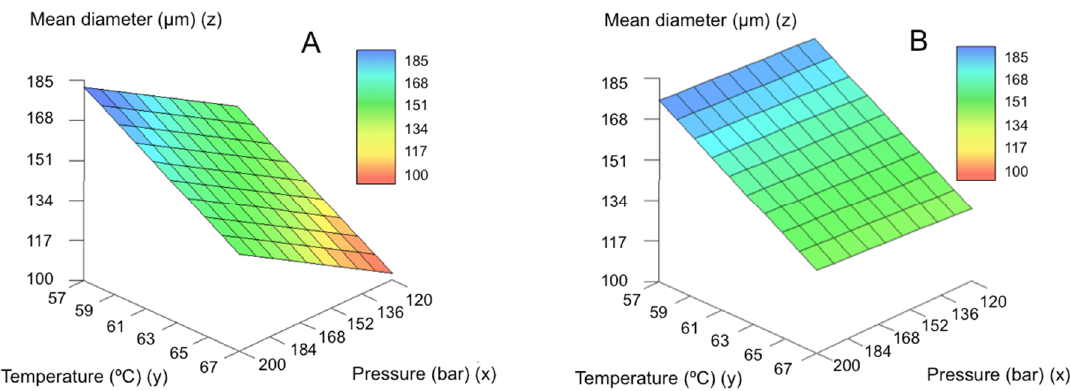
Figure 5. Predicted results by the model for mean particle size for the ( A ) large and ( B ) small nozzles.